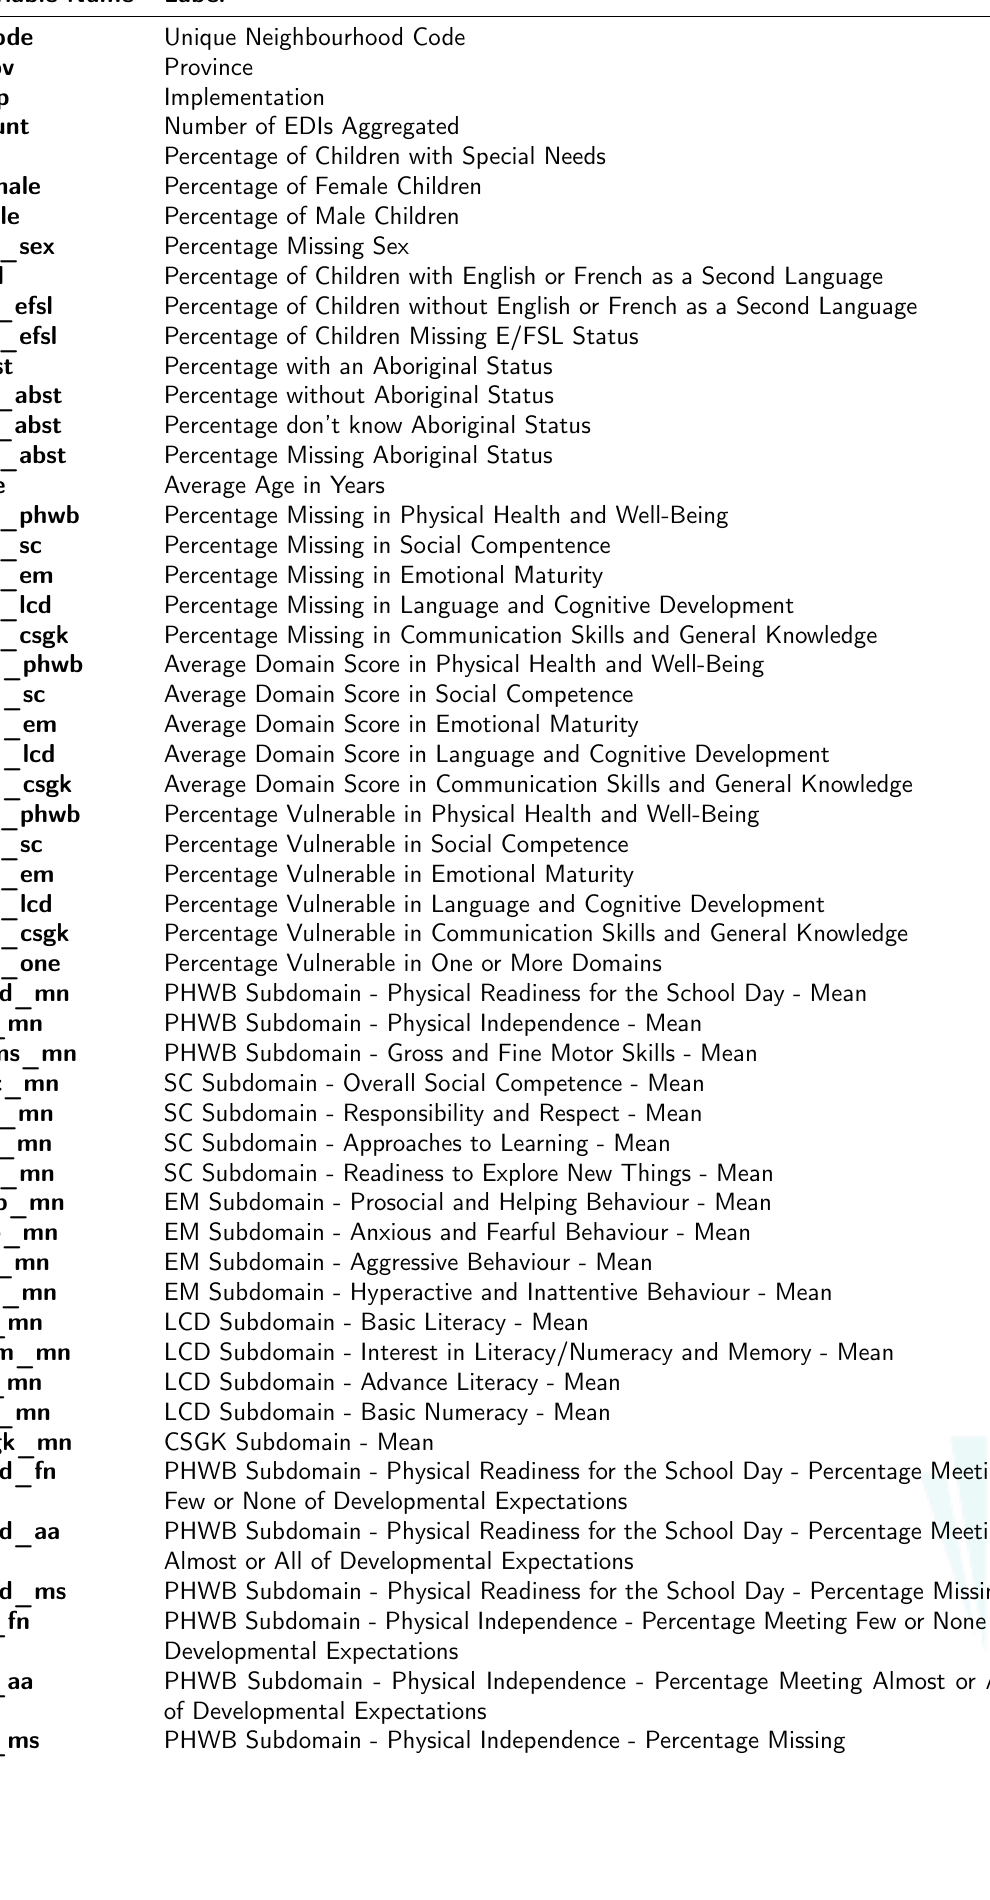
Supplemental Table 1. Early Development Instrument Variables in the CanNECD Database Variable